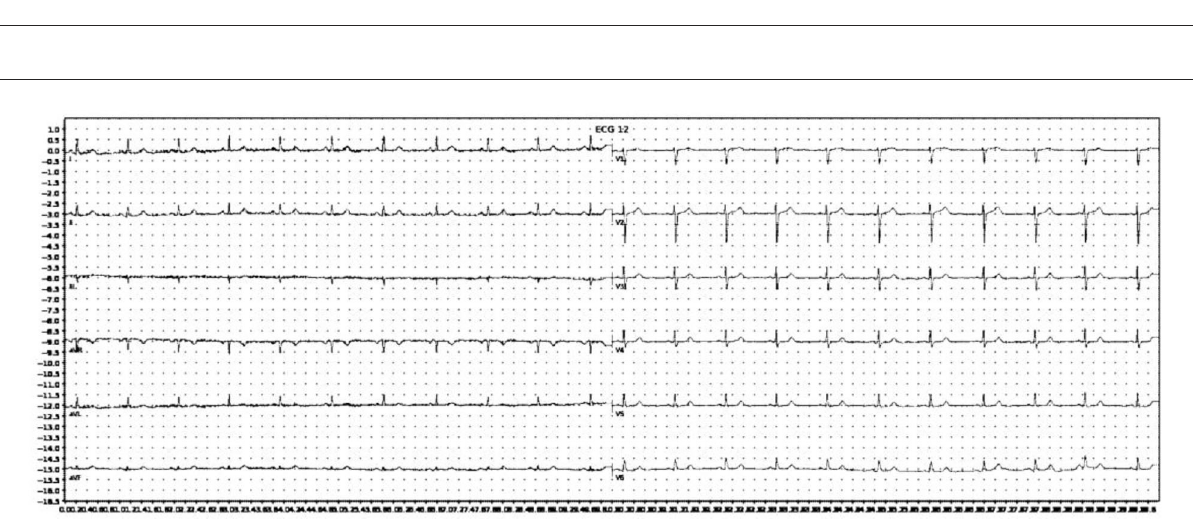
FIGURE1 Example of an ECG image generated from the signal data of one sample in the dataset.